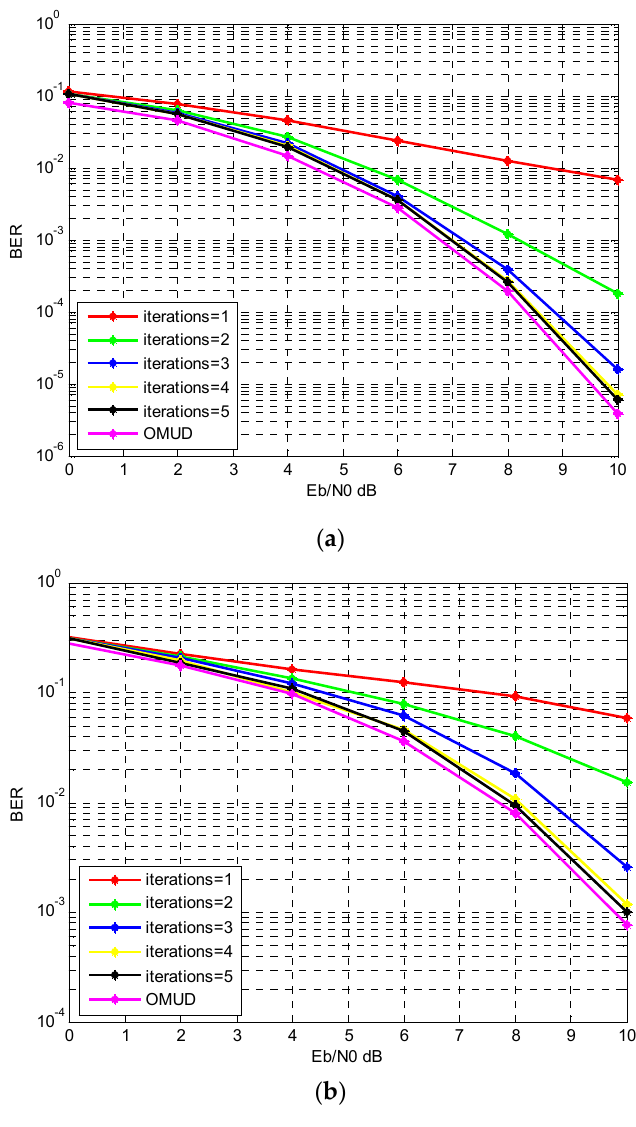
Figure 5. The BER performance with different number of iterations (50 users). ( a ) AWGN; ( b ) IEEE 802.15.4a CM1.